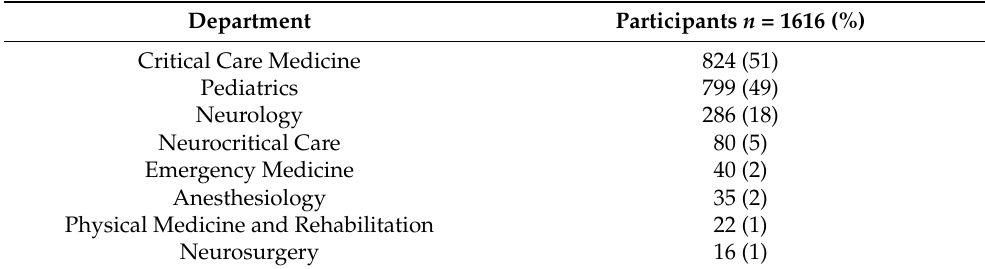
Table 3. Self-reported department(s) affiliations of participants in the Pediatric Neurocritical Care Education Series.